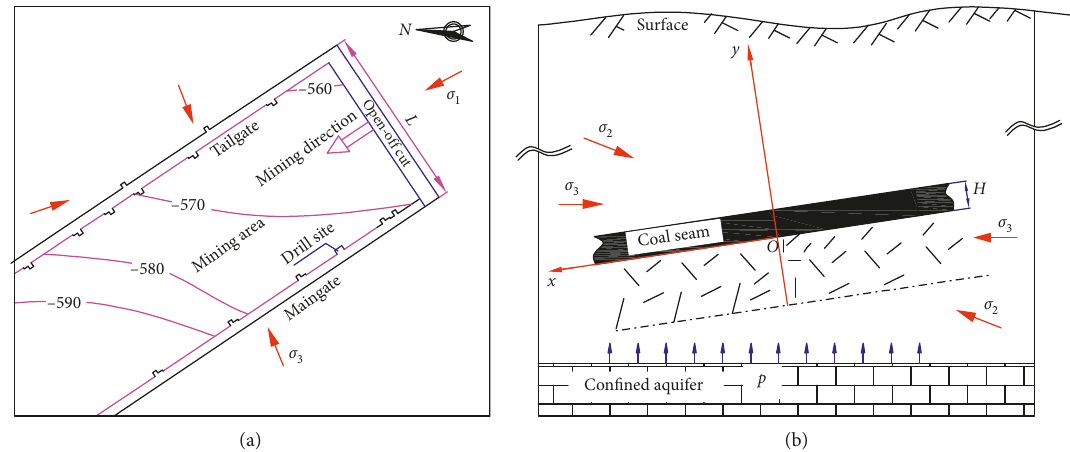
Figure 3: Spatial form of a working face and in situ stress conditions on a (a) plan view and (b) sectional view.